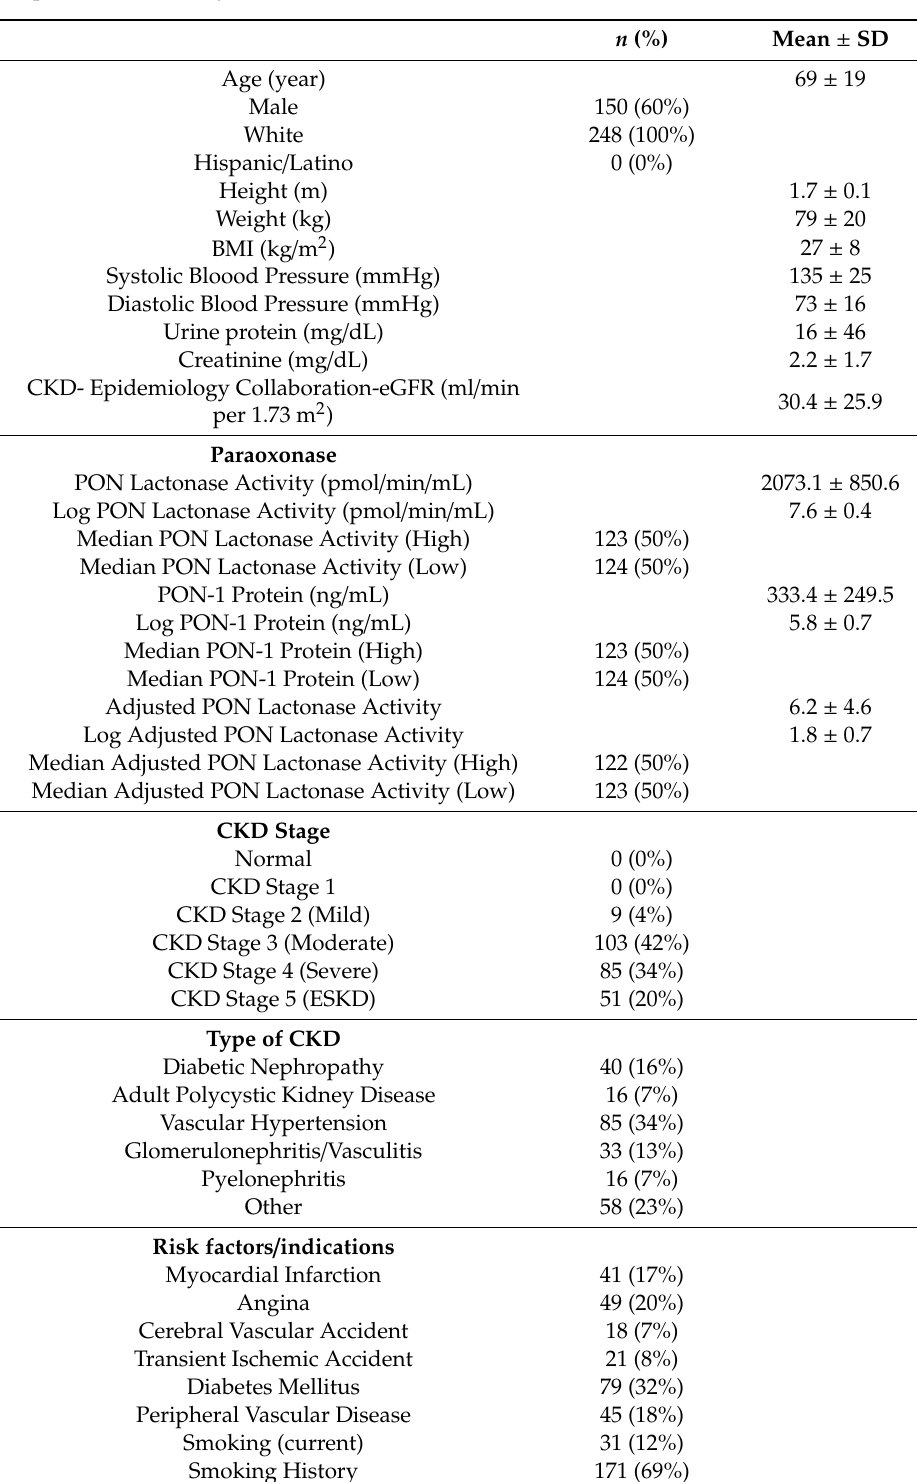
Table 1. Clinical characteristics among the participants in the Chronic Renal Insu ffi ciency Standards and Implementation Study